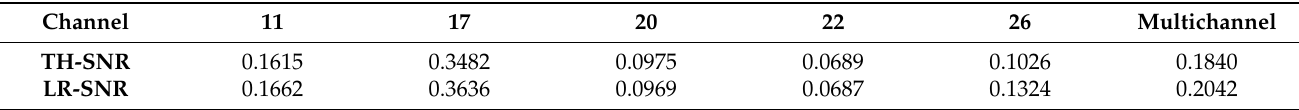
Table 4. RMSEs of the models of SNR and PRR under single-channel and multichannel scenarios.